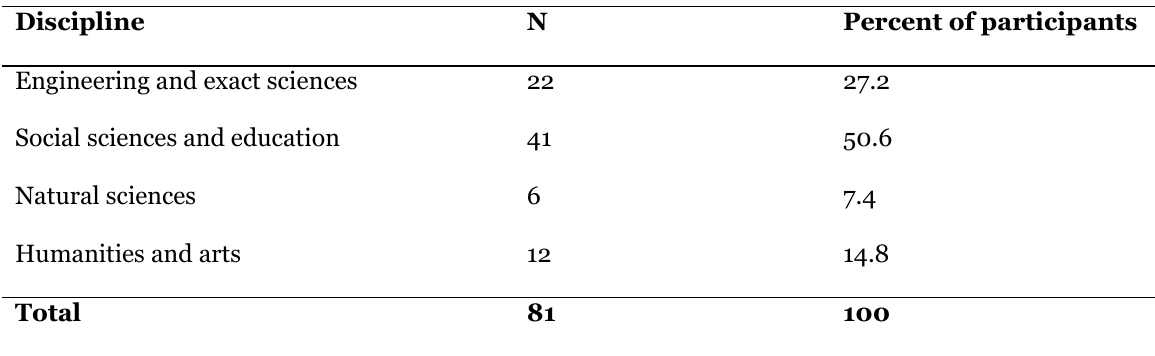
Distribution of Participants by